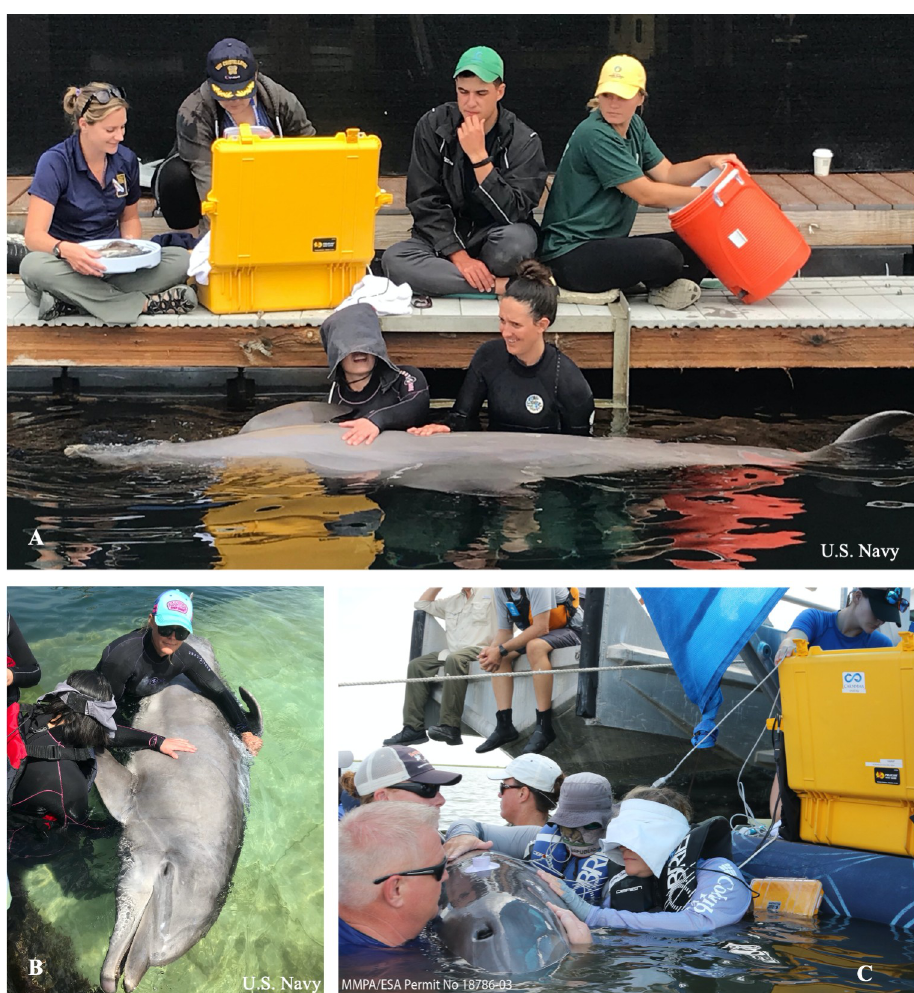
platform (B). (Republished from the U.S. Navy under a CC BY license, with permission from U.S. Navy, original copyright 2021.) (C) Transthoracic echocardiogram being performed on a dolphin in BB, while the animal is gently restrained in an obliqued orientation beside a